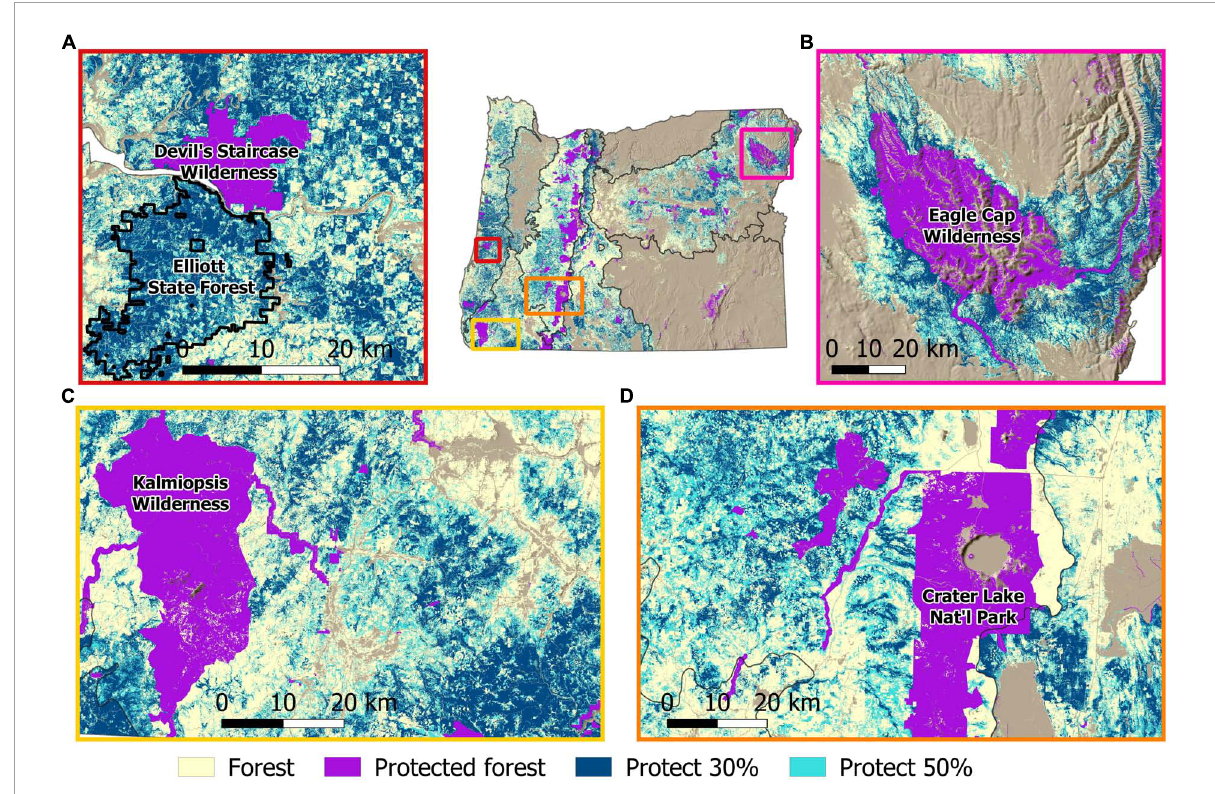
FIGURE4 Close-up examples of forestlands prioritized to meet preservation targets in Oregon. Examples include forestlands around the (A) Devil’s Staircase Wilderness and Elliot State Forest in the Coast Range, (B) Eagle Cap Wilderness in the Blue Mountains, (C) Kalmiopsis Wilderness in the Klamath Mountains, and (D) Crater Lake National Park in the Cascade Mountains. In these examples, forestlands were jointly prioritized using carbon, biodiversity, and climate resilience